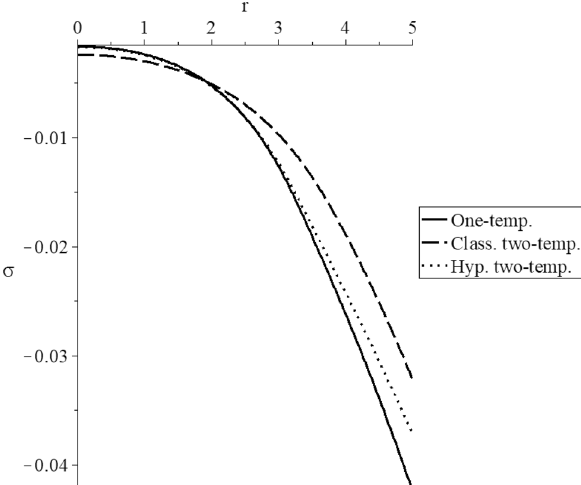
Figure 7. The average stress distribution for different models.